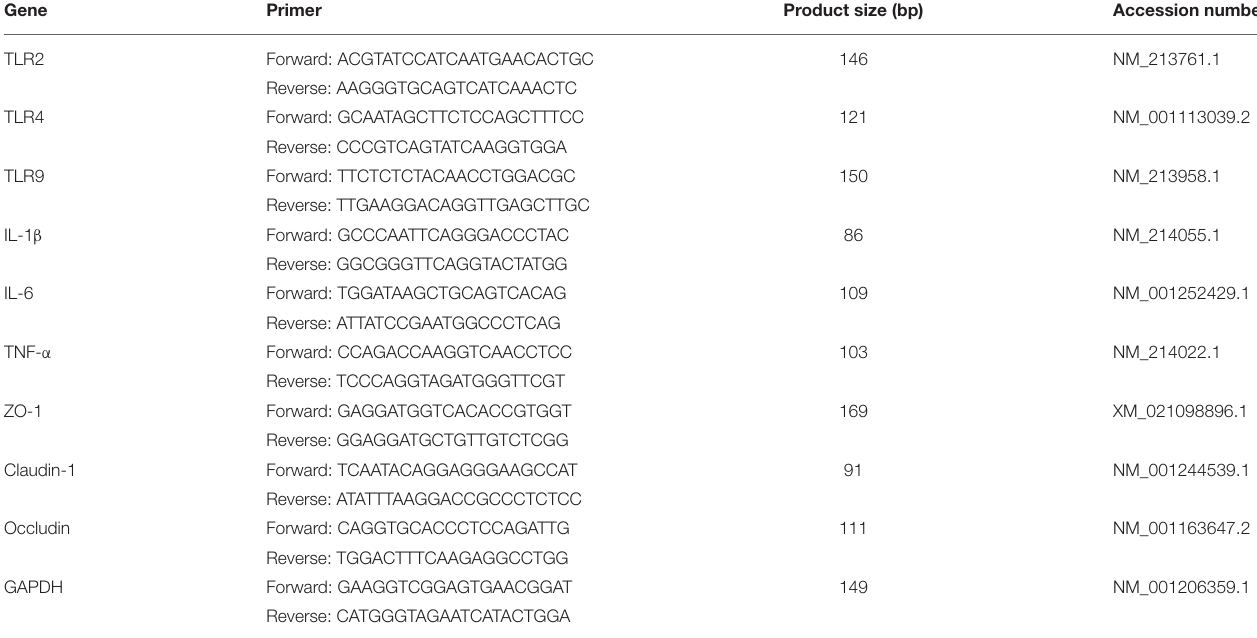
TABLE 2 | Specific primers used for real-time quantitative PCR. Gene